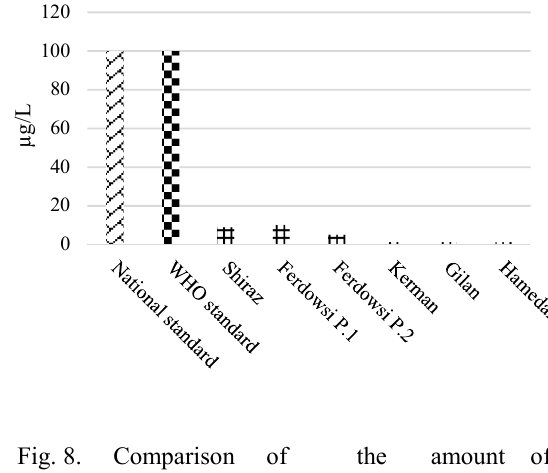
Fig. 5. Comparison of the amount of potassium to the national and global standard